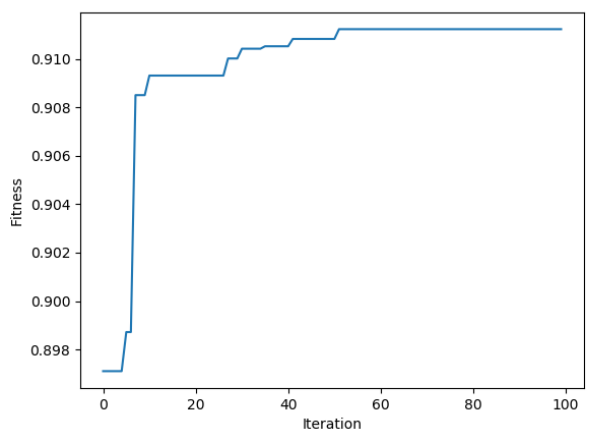
Figure 3. Optimal fitness of 100 generations.